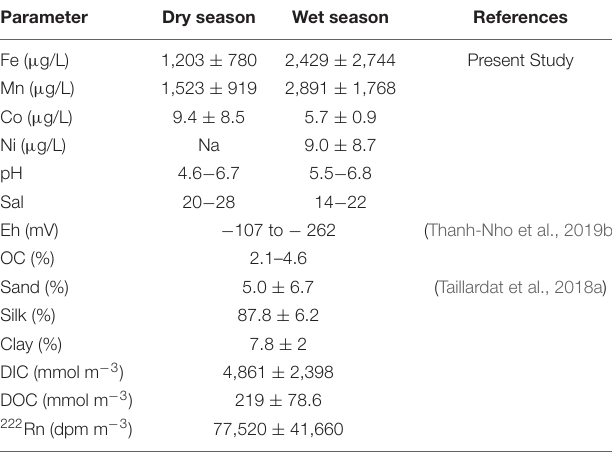
TABLE 2 | Characteristics of mangrove sediments and